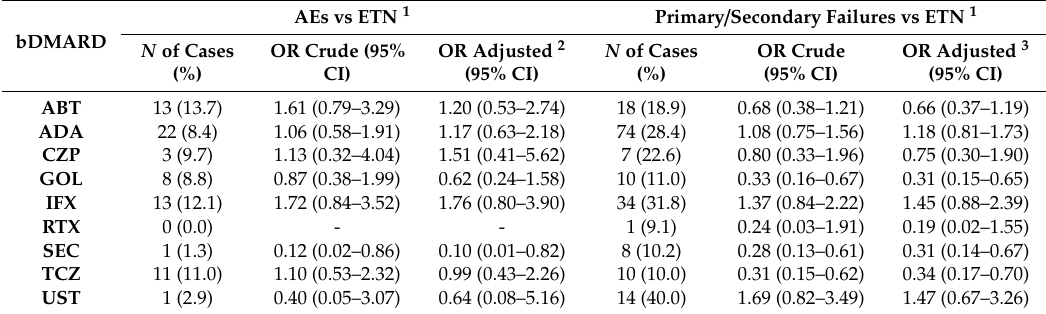
Table 2. Safety risk profile and treatment failures of bDMARDs compared to